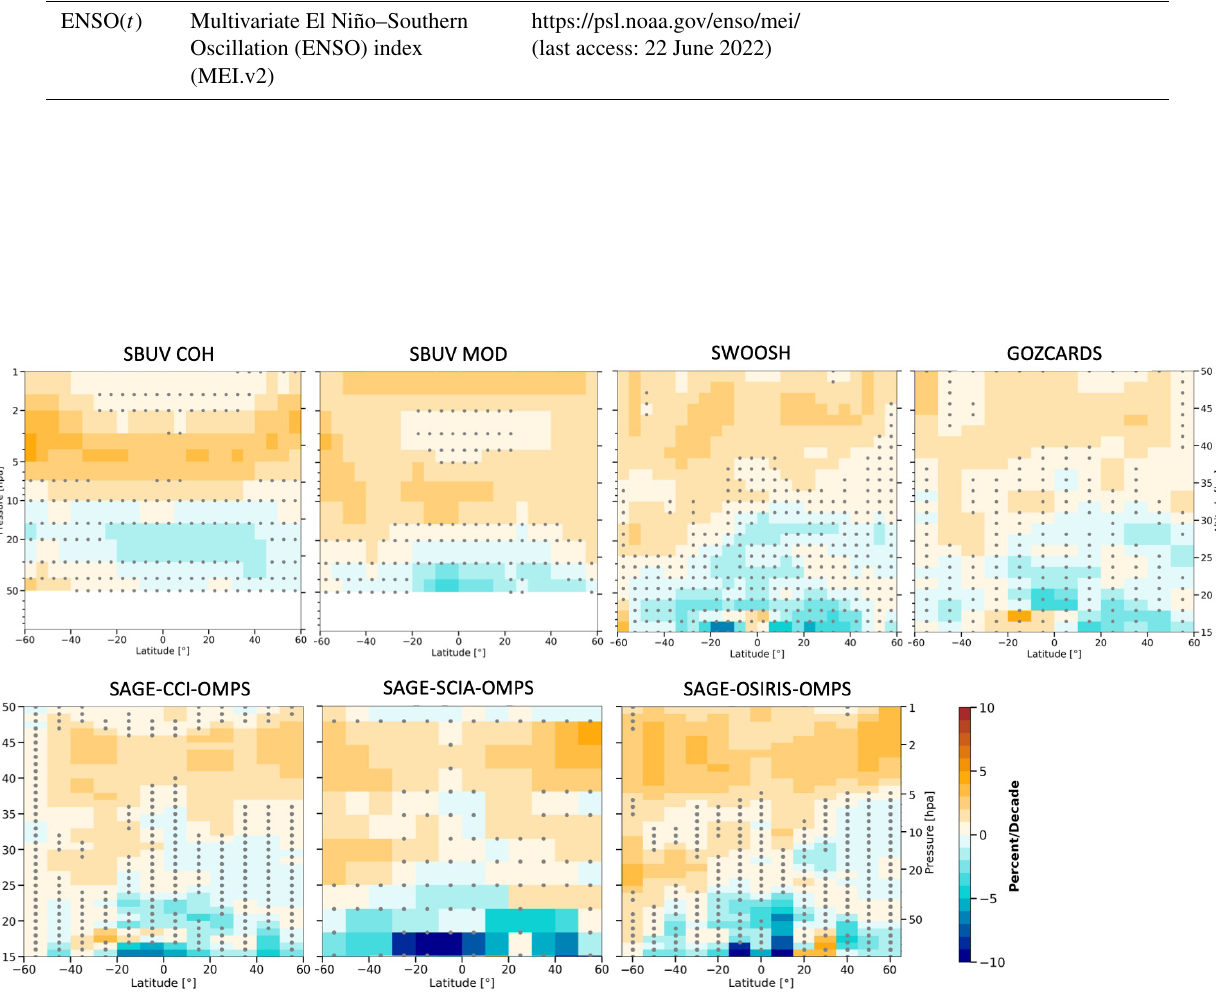
Figure 1. Ozone profile trends from merged satellite records in percent per decade for the post-2000 period (January 2000–December 2020). Grey stippling denotes results that are not significantly different from zero at the 2 σ level. Data are presented on their native latitudinal grid and vertical